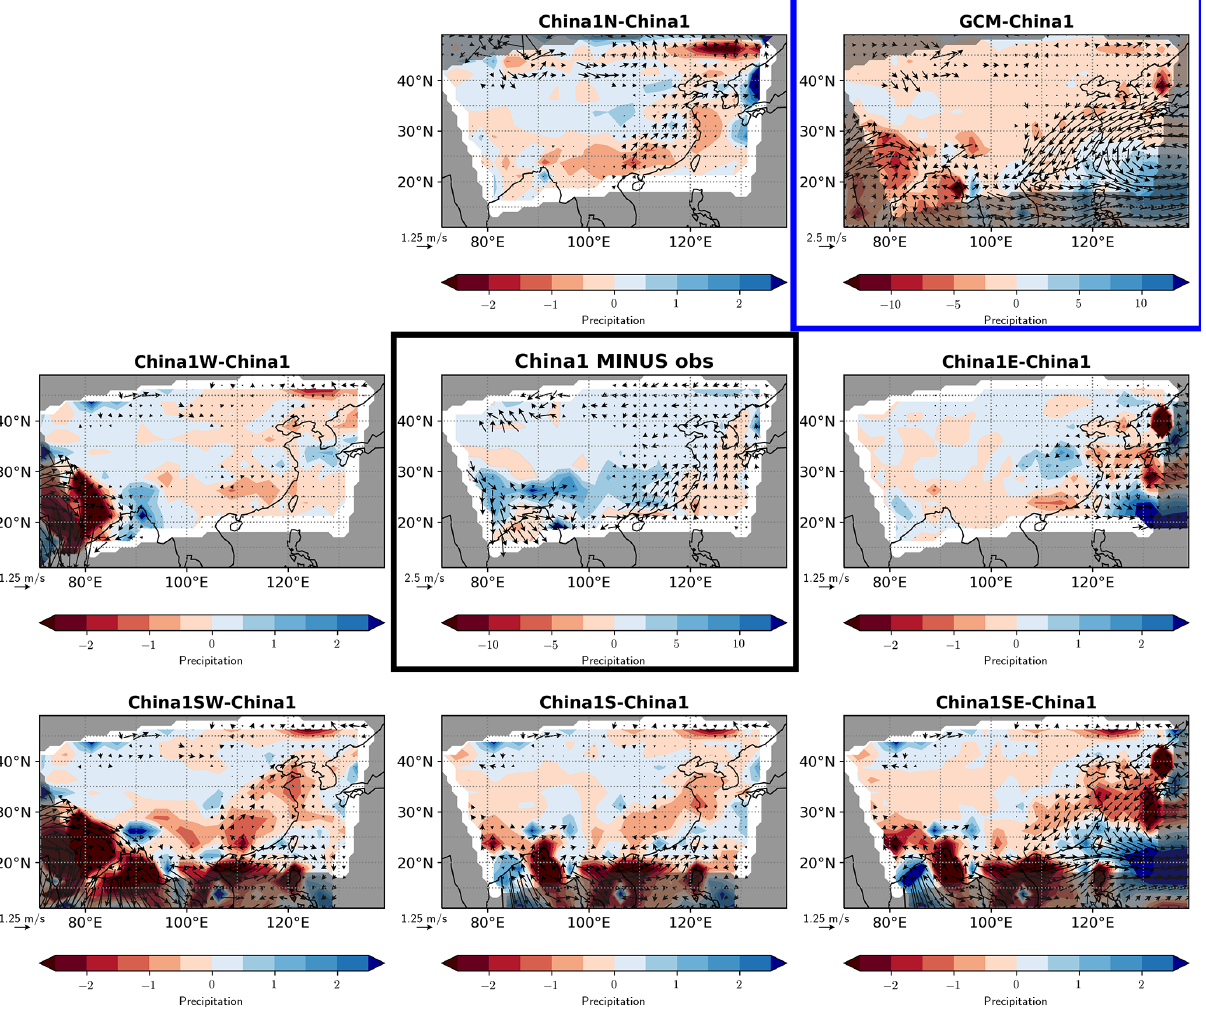
Figure 5. Effects of extending the China1 domain in different directions, as indicated in Fig. 3. Differences are in comparison with China1 in each case (except outside the China1 region, where they are differences from observations), while the centre panel shows China1 minus observations. Note the differences in contour interval and vector scale between the centre and top right panels and the other panels. Plots are for JJA (1989–2008). Colour bar indicates precipitation differences (mmd − 1 ) and vectors indicate differences in 850hPa